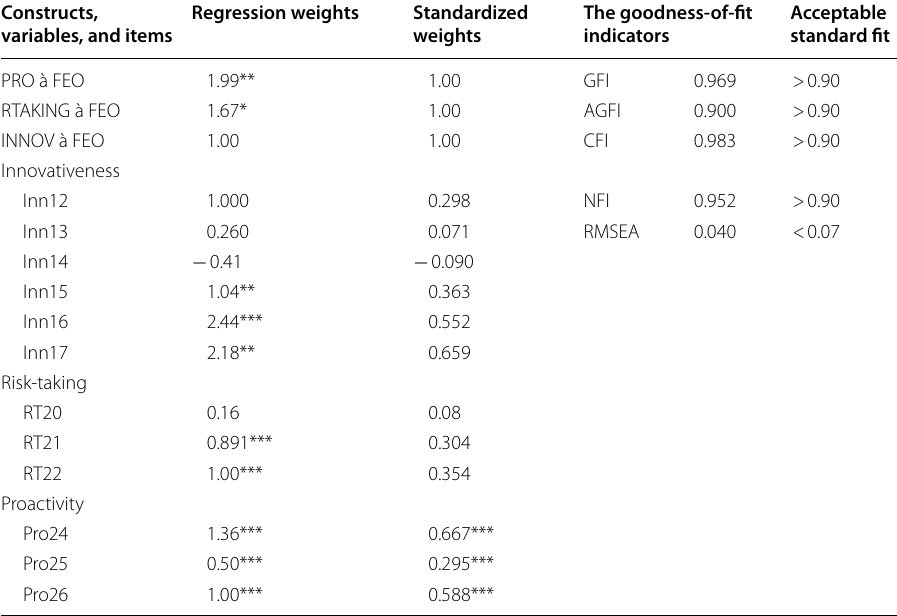
Table 3 Statistics of measurement analysis